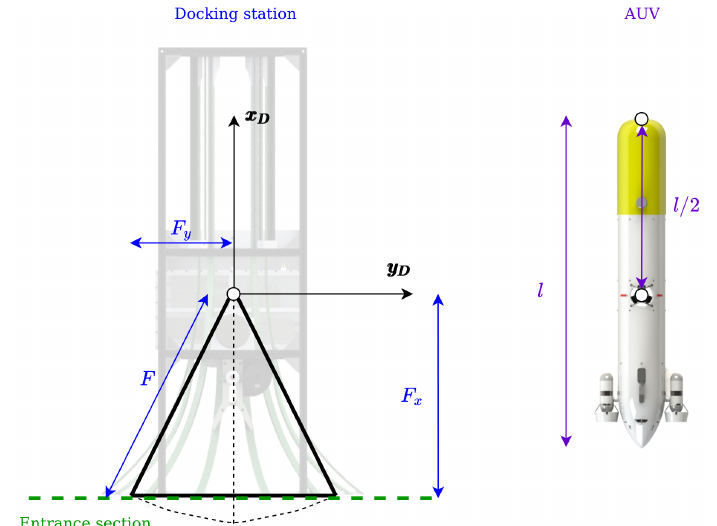
Figure 4. Geometrical problem simplification.